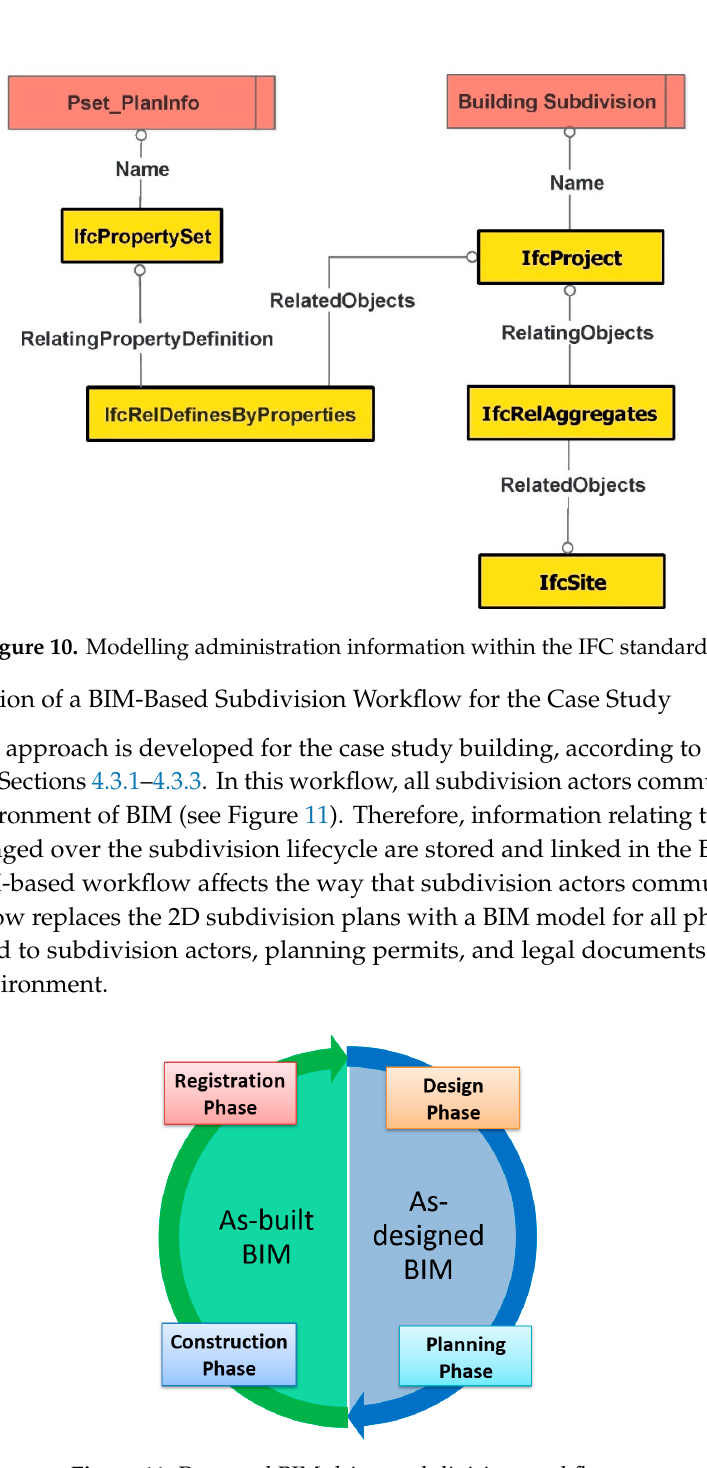
Table 4. Attributes of “IfcSite” for managing survey header information (extracted from [46]).